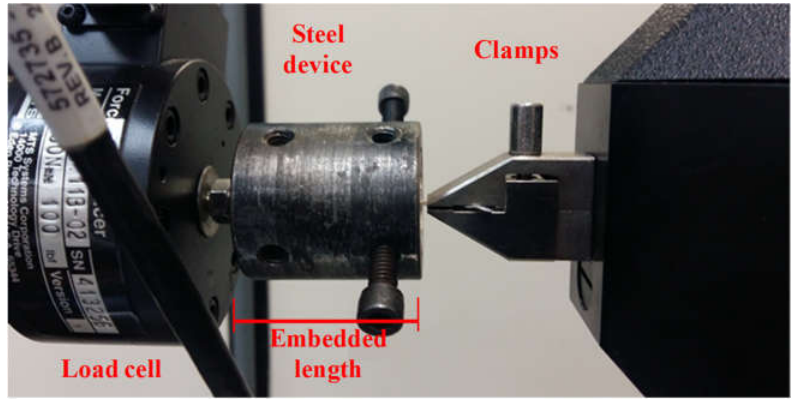
Figure 5. Pull-out test set up.